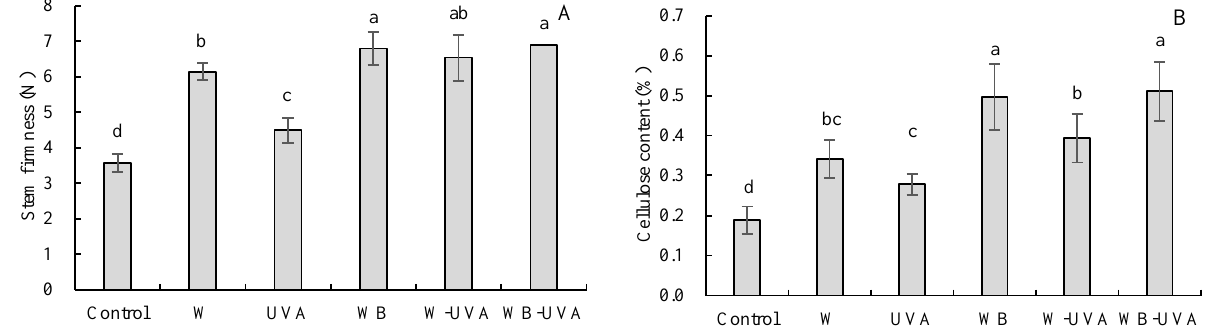
Figure 2. Effects of supplementary light provided by white (W), UV-A light-emitting diodes (LEDs), and various combinations of W, blue (B), and UV-A LEDs on stem firmness ( A ) and cellulose content ( B ) of greenhouse-grown cucumber seedlings cultivated for 22 days after sowing; cucumber seedlings grown without supplementary light were used as control. Different letters within each parameter were significantly different tested by the least significant difference (LSD) test at p < 0.05.